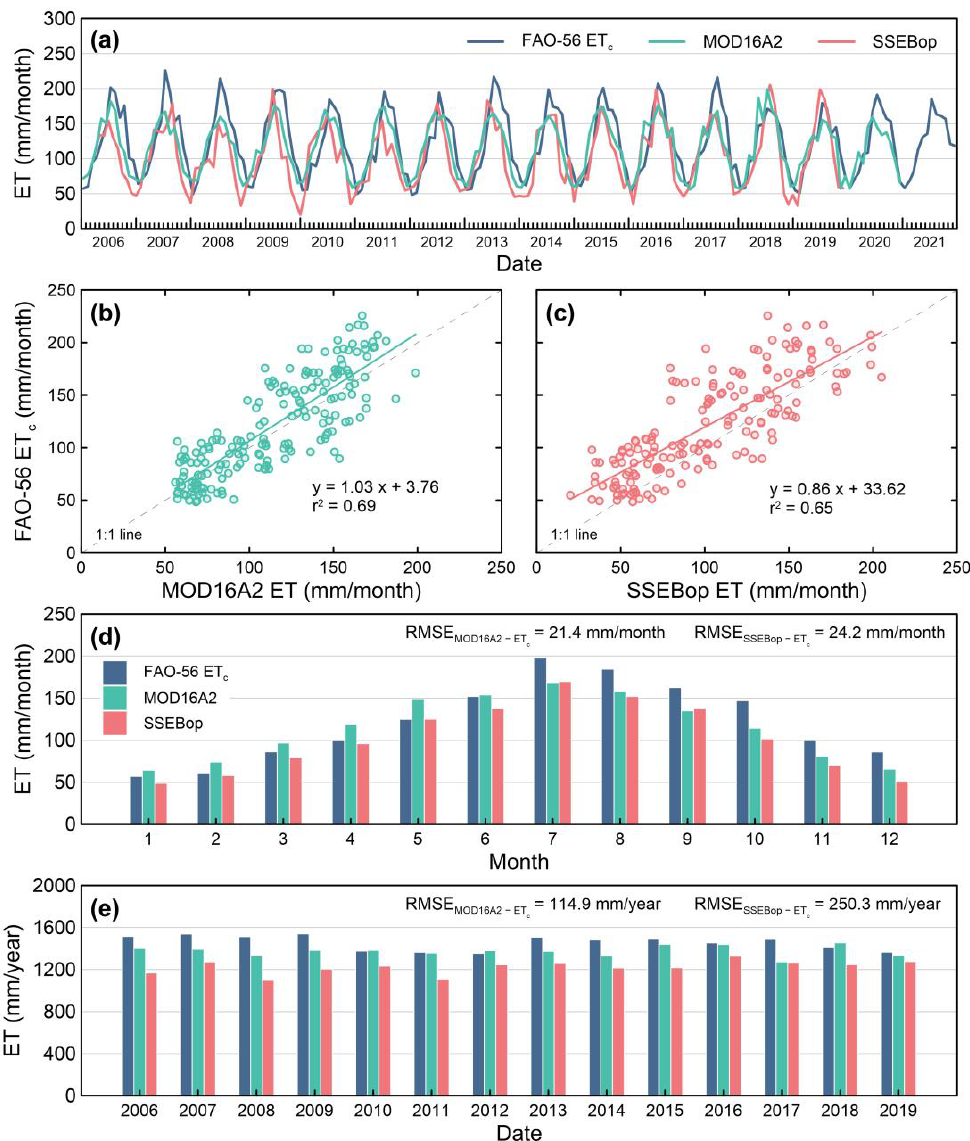
Figure 4. Comparison of three ET estimations (ET c , MOD16A2, and SSEBop) for 2006‒2019. ( a ) Monthly variations in comparison; ( b ) correlation of actual crop evapotranspiration (ET c ) and MOD16A2 ET; ( c ) correlation between ET c and SSEBop ET; ( d ) comparison of average ET for each month; ( e ) comparison of annual ET from three estimates. RMSE is root mean square error.